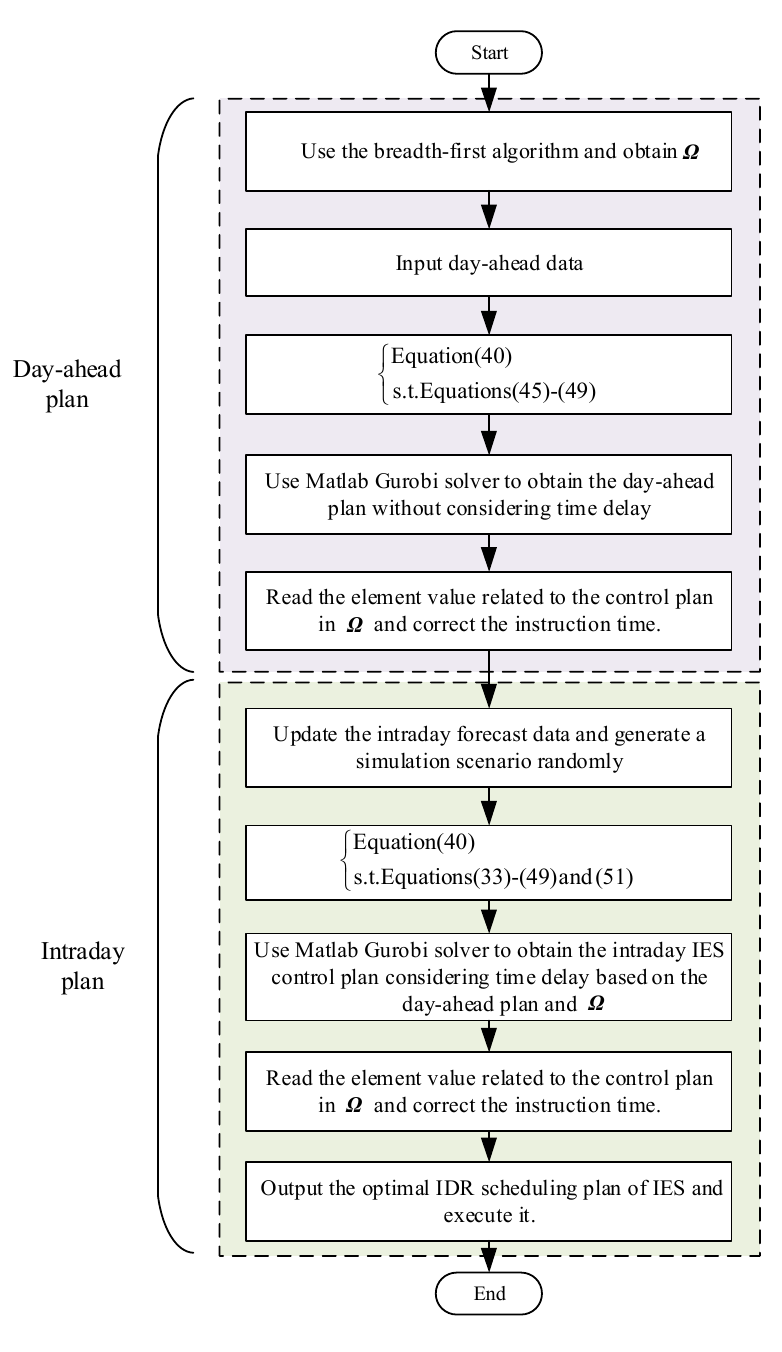
Figure A1. The designed process of